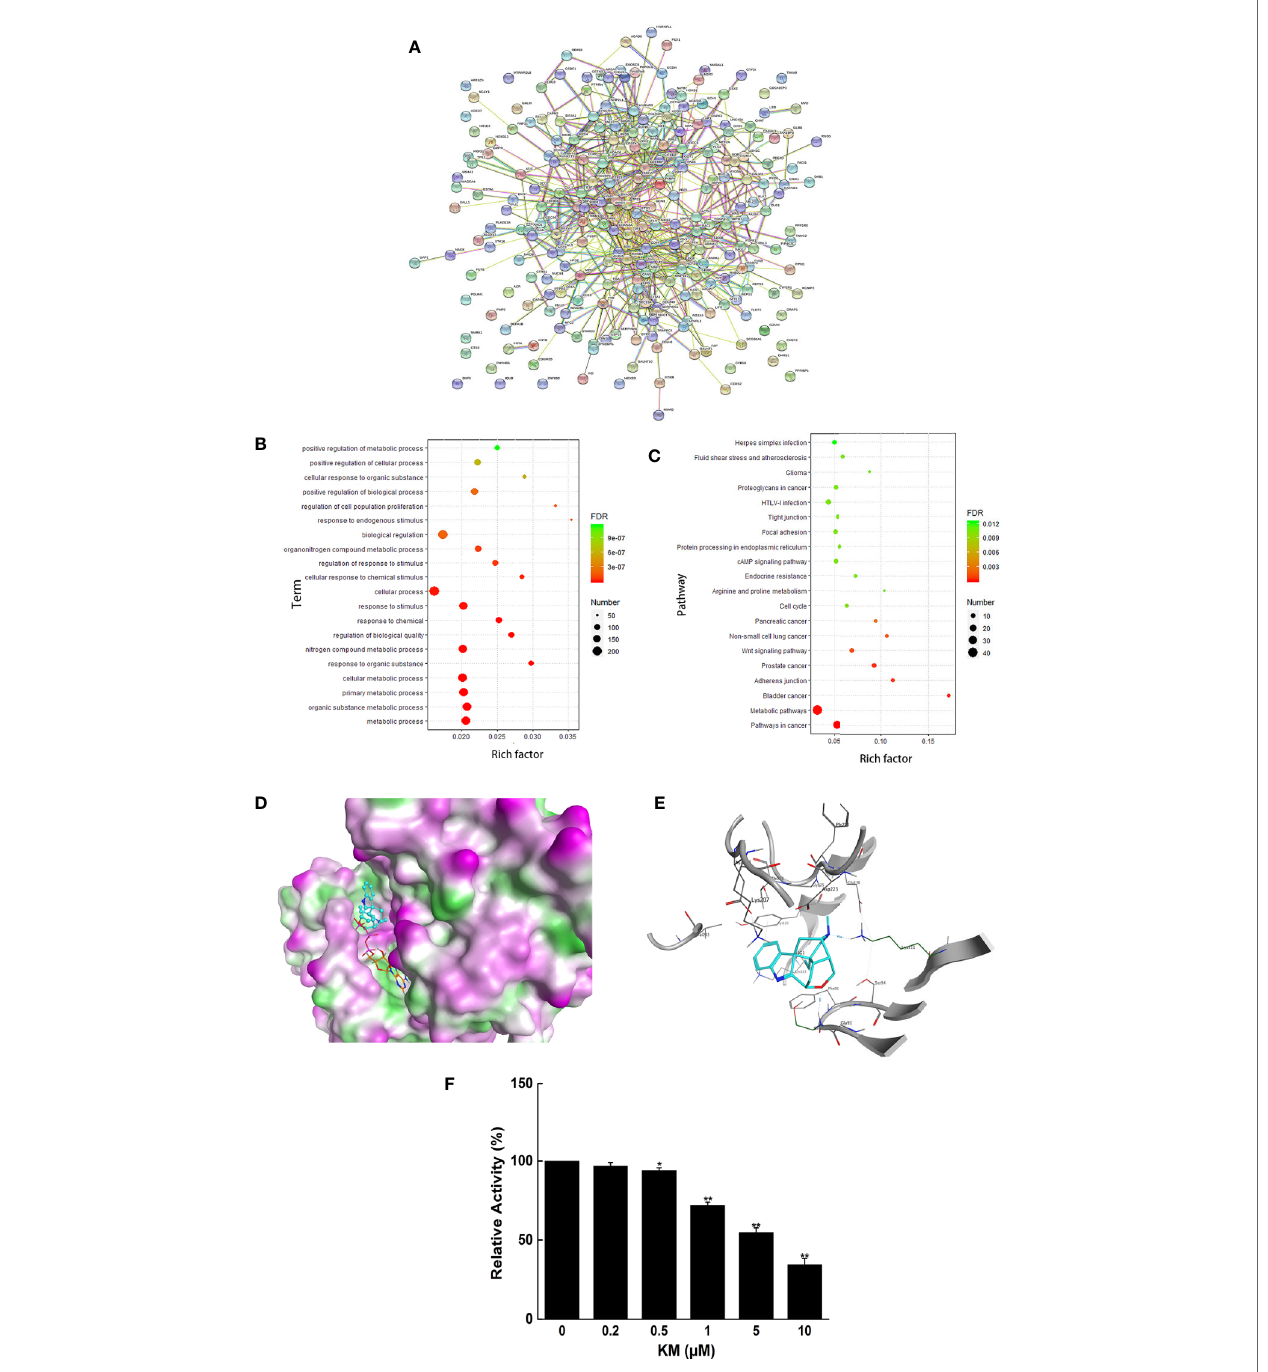
FIGURE 2 | (A) Clusters of screened PPI networks (B) The 20 representative terms with the lowest P value of biological process (BP) gene ontology enrichment. (C) The top 20 pathways with P < 0.05 of KEGG pathway enrichment. (D) Molecular interaction of KM with PDK1. (E) The 2D representation of KM docking pose with PDK1. (F) The effect of KM on PDK1 kinase activity. Data were shown as mean ± SD (n = 3); signi fi cance: * P < 0.05, ** P < 0.01 vs